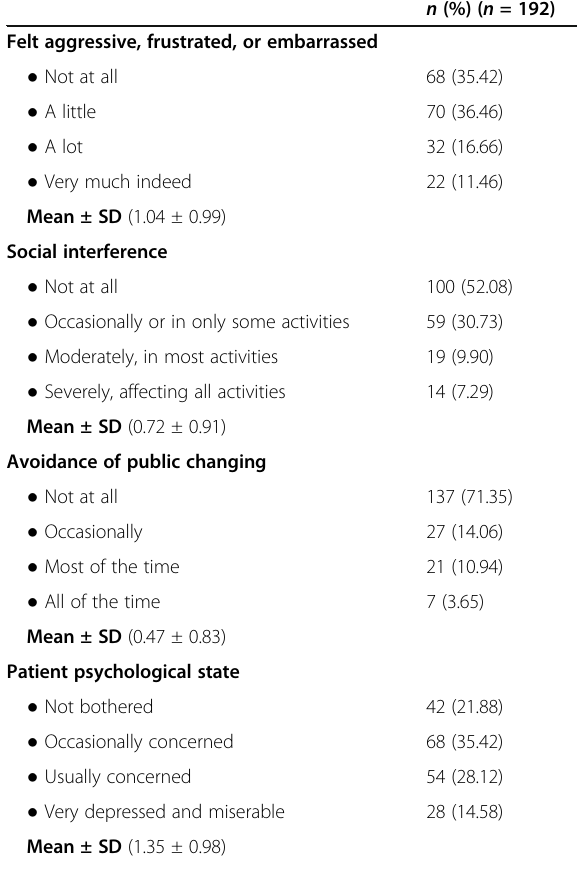
Table 2 Specific responses to Cardiff Acne Disability Index